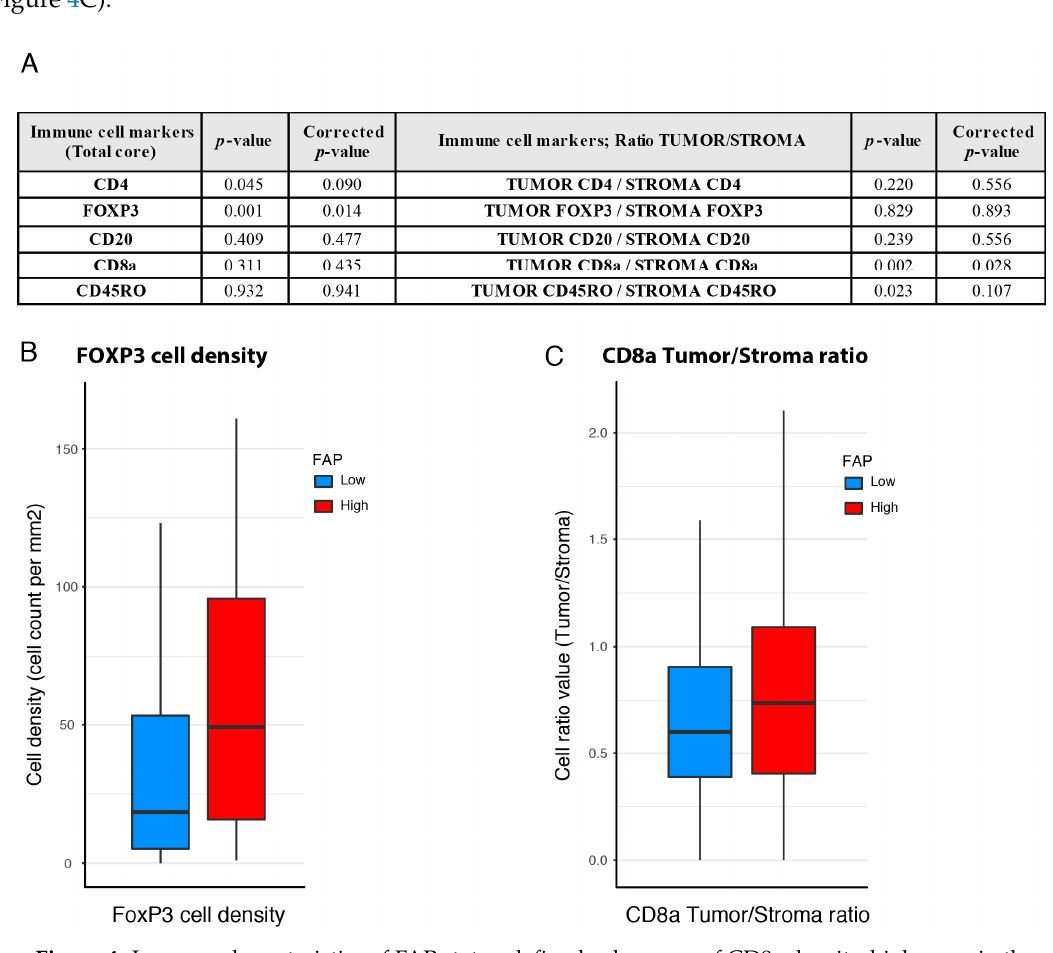
Figure 4. Immune characteristics of FAP status-defined subgroups of CD8a density-high cases in the U-CAN population. ( A ) Total tumor densities and ratio of the epithelial-to-stromal density of immune markers in the FAP intensity-defined cases. ( B ) FoxP3 density in the FAP intensity-defined groups within the CD8a density-high cases. ( C ) The ratio of epithelial-to-stromal density of CD8a density cells in the FAP-defined groups within the CD8a density-high cases.